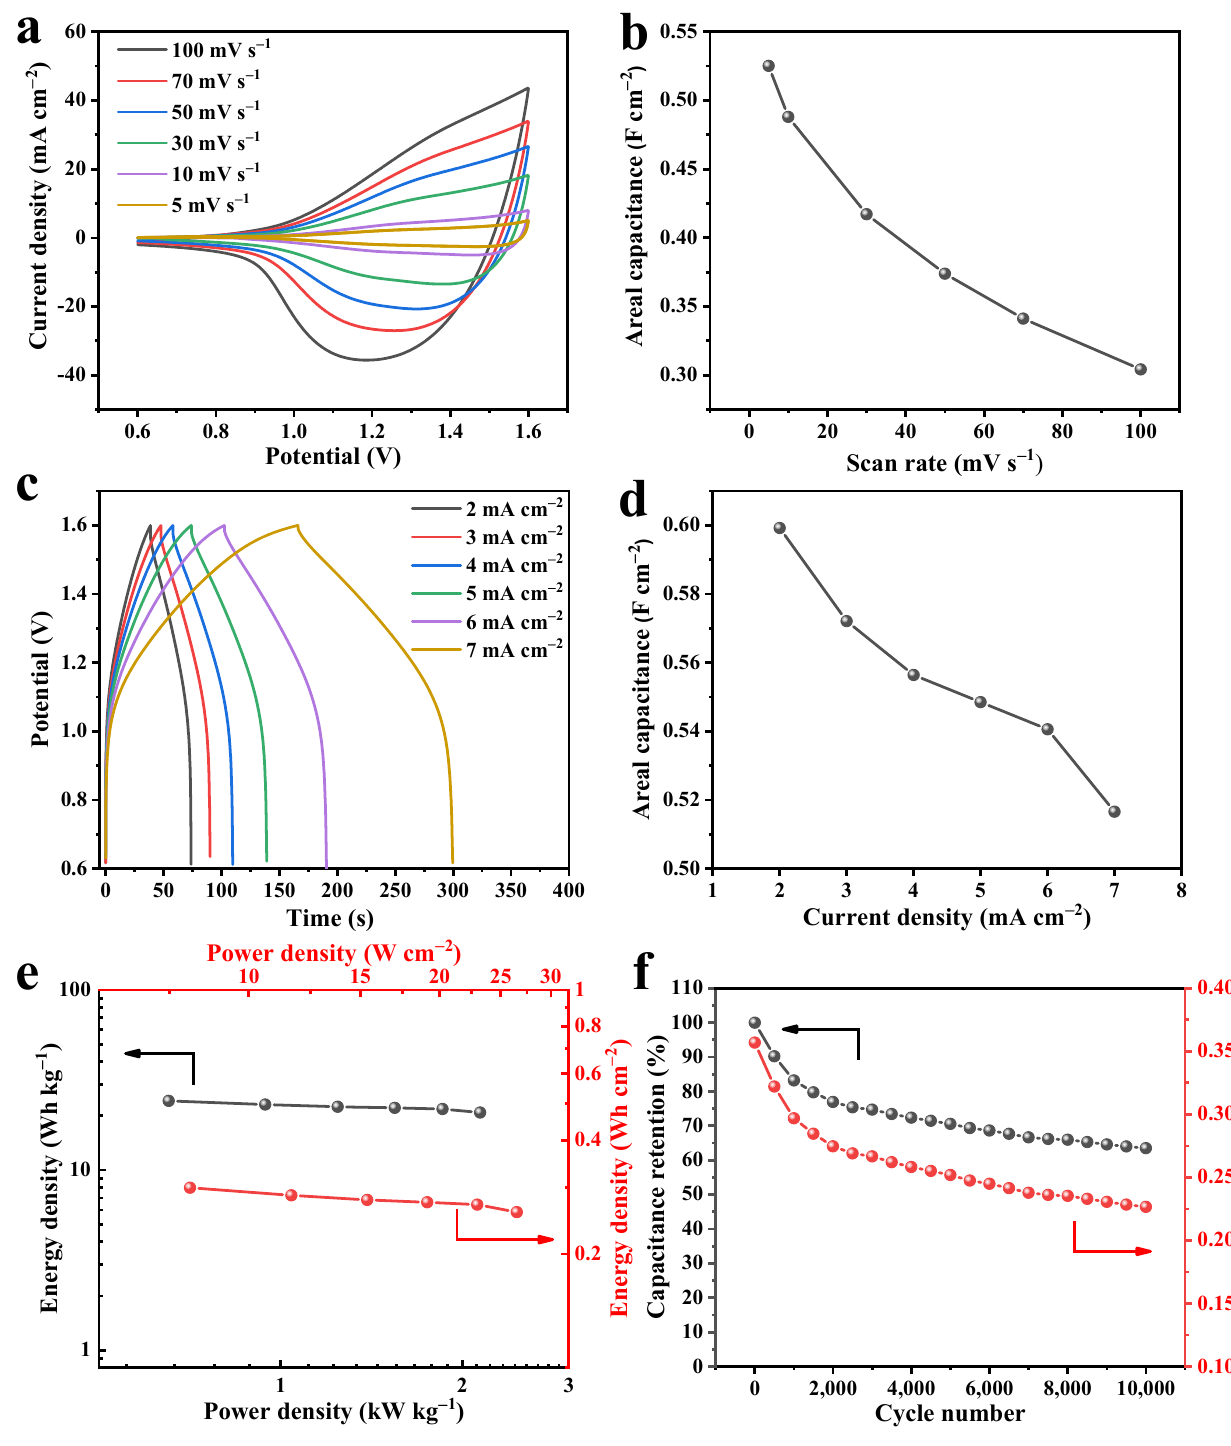
Figure 6. Electrochemical performance of the O-Cu-2h//AC asymmetric supercapacitor in the 1 M KOH solution. ( a ) CV curves at various scan rates. ( b ) Areal capacitance as a function of scan rate. ( c ) GCD curves at different current densities. ( d ) Areal capacitance as a function of current density. ( e ) Ragone plots of the O-Cu-2h//AC asymmetric supercapacitor. ( f ) Stability of the device for 10k cycles.